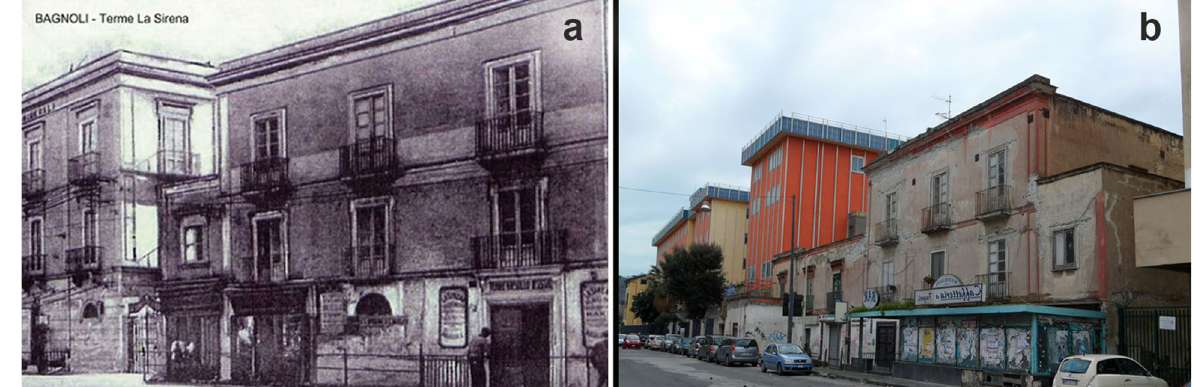
Fig. 2. The Sirena thermal facility in around 1940 (a) and in 2018 (b). Source: G. Masullo – private archive (a); photographed by M. Noviello